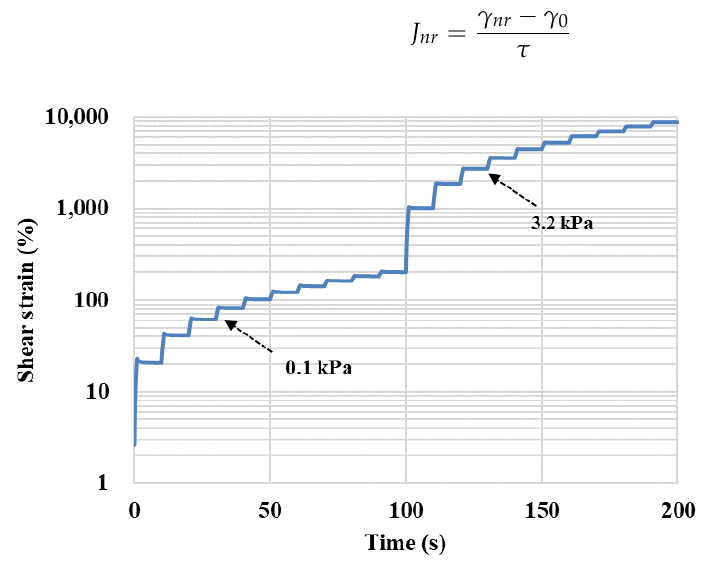
Figure 3. A typical shear strain curve in a MSCR test.